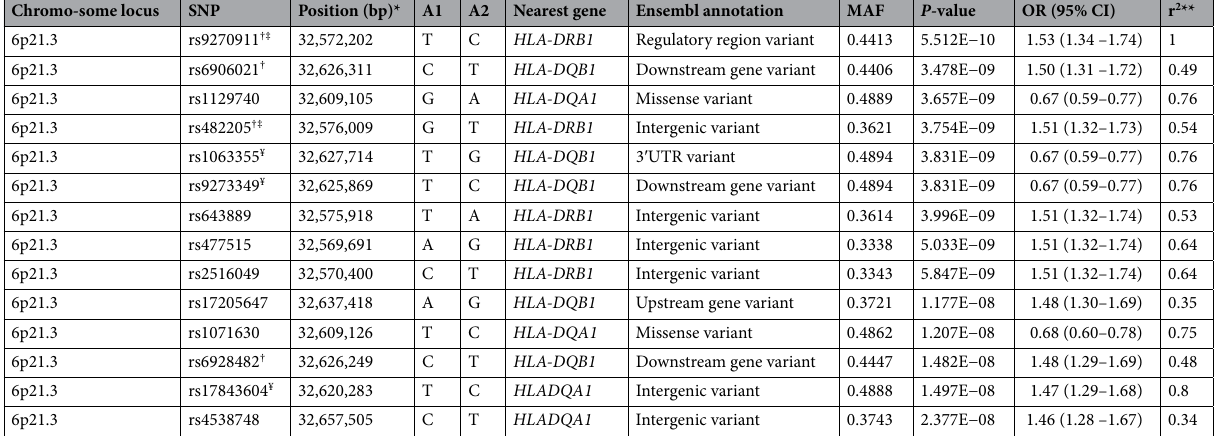
Table 1. Genome-wide significant results from a genome-wide association study (GWAS) on podoconiosis undertaken in three ethnic groups (Amhara, Oromo and Wolaita, dataset 1) from Ethiopia. SNP, single nucleotide polymorphism; A1, minor allele; A2, major allele; MAF, minor allele frequency; HWE, Hardy– Weinberg equilibrium. *The position is based on the University of California Santa Cruz (UCSC)